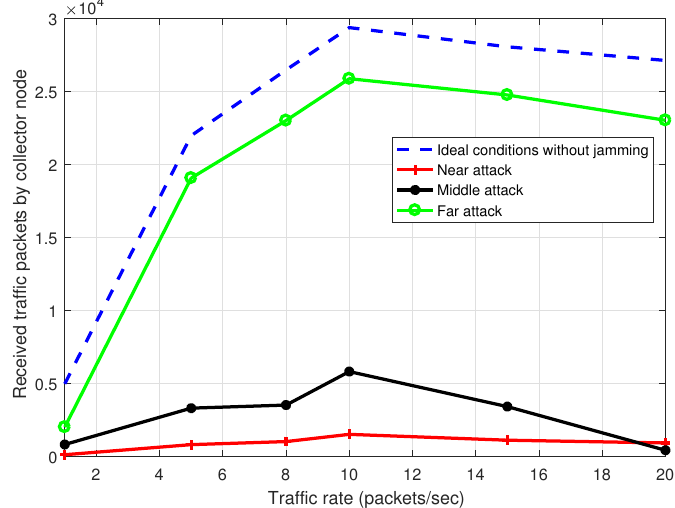
Figure 15. System throughput with ideal conditions and under attack with the jammer node is located near, in the middle and far from the collector node.